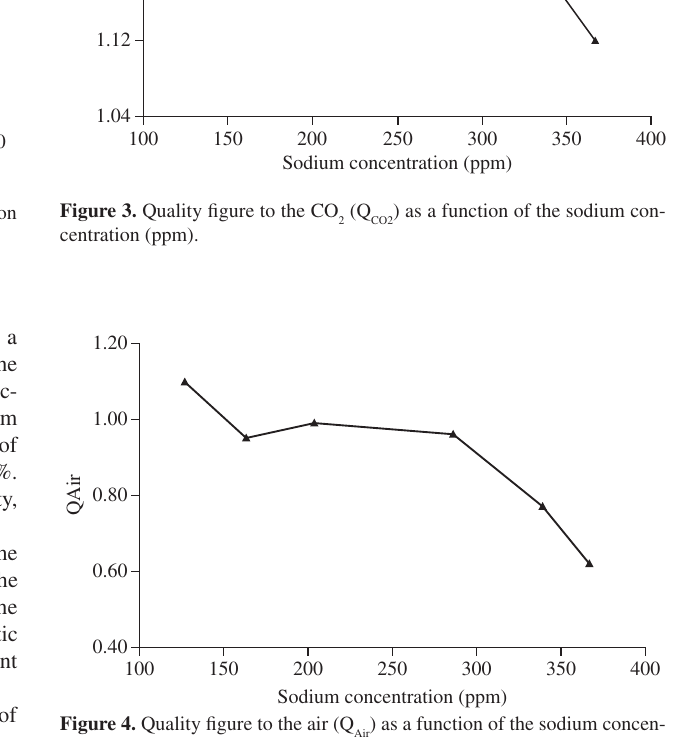
) as a function of the sodium concen- Air